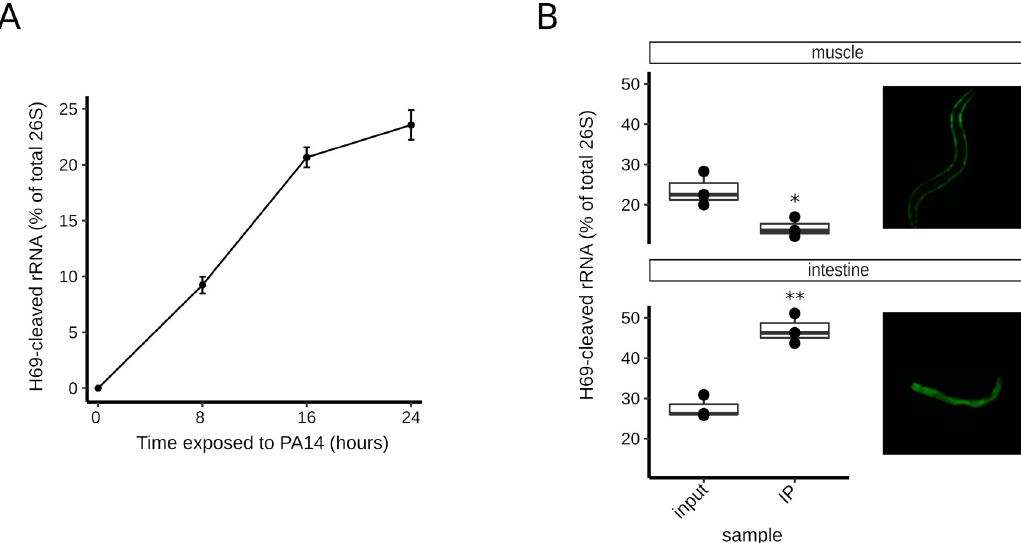
Fig 3. Dynamics of H69 cleavage. (A) Graph of H69 cleavage levels in relationship to adult worm exposure time to PA14 (in hours). The average of tree measurements per timepoint and SD (error bars) is plotted. (B) H69 cleavage levels in 2 major worm tissues. Worms with GFP-tagged ribosomes in the muscle (top panel, JAC127 strain) and intestine (bottom panel, JAC382 strain) were exposed to PA14 for 24 h, followed by tagged ribosome IP and RNA analysis. The H69 cleavage levels for whole worms (labeled “input”) and the corresponding “IP” ribosomes are plotted. For all graphs, “ � ” indicates p -value < 0.05, and “ �� ” represents p -value < 0.01 for Welch t test comparisons between the plotted conditions. S1 Data contains source data for all panels. GFP, green fluorescent protein; H69, helix 69; IP, immunoprecipitation; SD, standard deviation.